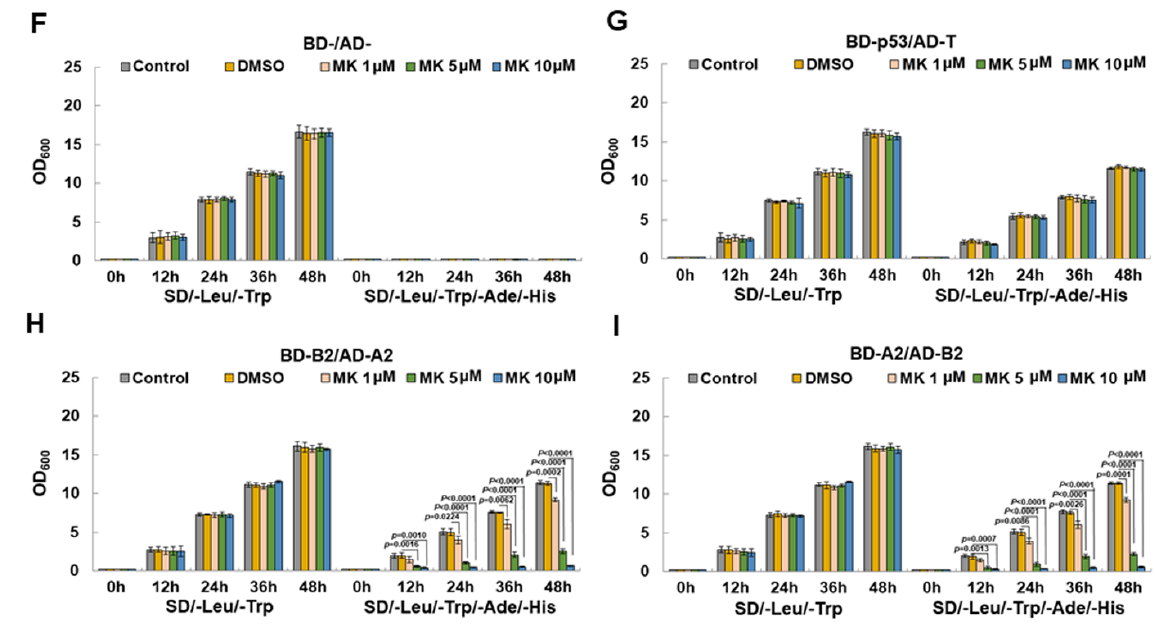
Figure 7. Maackiain (MK) directly inhibits the interaction of BCAS1-SV1 with β -arrestin 2 in a yeast two-hybrid-based growth assay. ( A ) Schematic showing the use of the yeast two-hybrid-based growth assay in identifying inhibitors of protein–protein interactions. ( B – E ) Log-phase cultures of yeast diploid cells containing plasmids encoding either ( B ) Gal4 BD-/Gal4 AD-, ( C ) Gal4 BD-p53/Gal4 AD-T, ( D ) Gal4 BD-B2 (BCAS1-SV1)/Gal4 AD-A2 ( β -arrestin 2), or ( E ) Gal4 BD-A2/Gal4 AD-B2 were washed in water and plated at different dilutions on nonselective (-Leu-Trp) and selective (-Leu-Trp- Ade-His) plates including different dilutions of MK and incubated at 30 ◦ C for 3 days. ( F – I ) Overnight cultures of yeast diploid cells containing plasmids encoding either ( F ) Gal4 BD-/Gal4 AD-, ( G ) Gal4 BD-p53/Gal4 AD-T, ( H ) Gal4 BD-B2 (BCAS1-SV1)/Gal4 AD-A2 ( β -arrestin 2), or ( I ) Gal4 BD-A2/Gal4 AD-B2 in nonselective medium were washed in water and inoculated into selective and nonselective media including different dilutions of MK at OD 600 = 0.2. For each strain, growth as measured by average OD 600 of triplicate cultures is plotted against